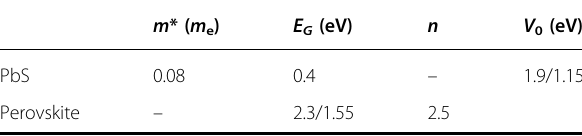
Table 1 Summary of the main properties of the PbS CQDs and Perovskite host, namely the effective mass, m